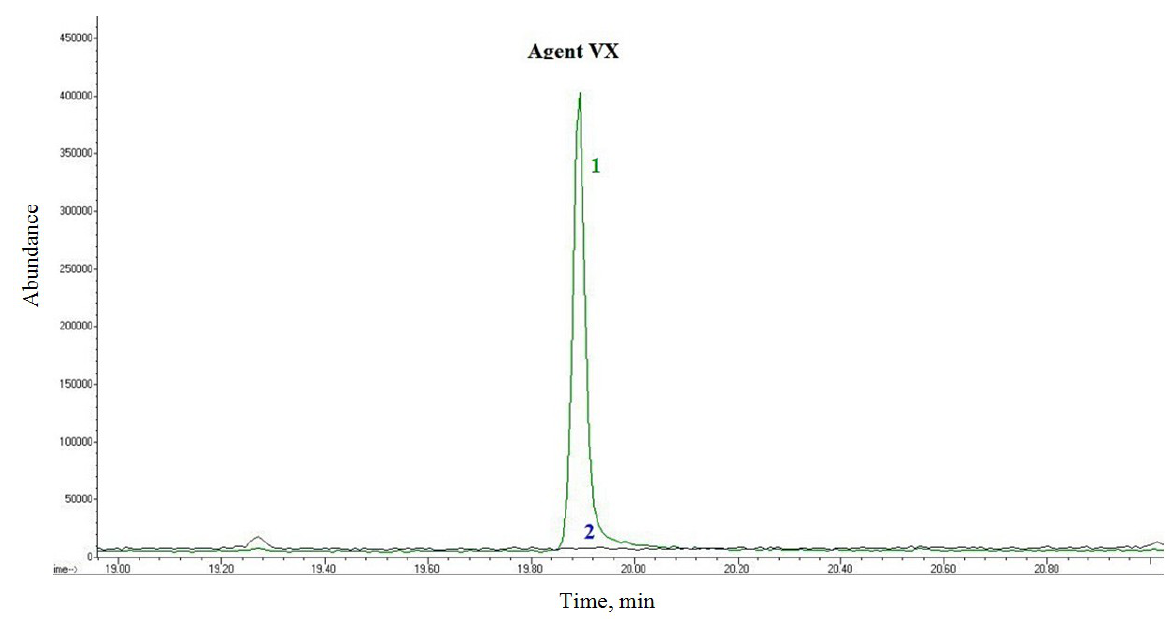
Figure 7. GC/MS chromatogram of O -ethyl- S -(diisopropylaminoethyl) methylthio-phosphonate (VX)-contaminated alcohol wipes after 24 h; 1—wipe without treatment, 2—wipe after treatment with solid sodium